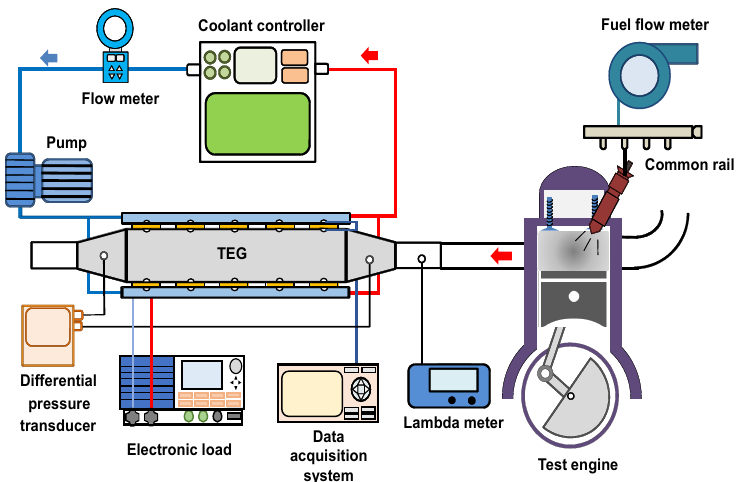
Figure 1. Experimental setup. The water-cooling heat exchanger and engine control unit are not shown.